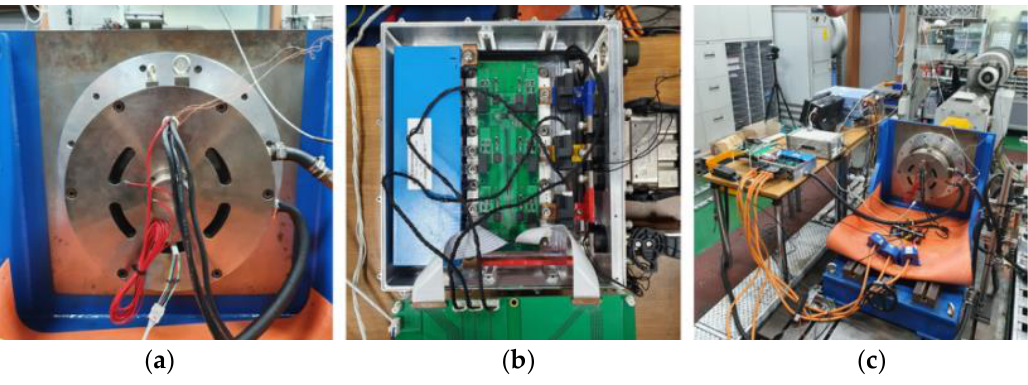
Figure 23. Pictures of the prototype and performance evaluation environment: ( a ) final prototype of motor applied with permanent magnet development product; ( b ) inverter Development; ( c ) semi-EMF demagnetization ratio experimental environment and diamagnetic current application device.